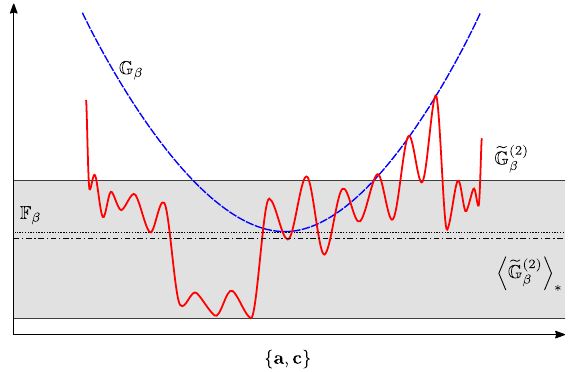
FIG. 2. Cartoon description for estimating the Helmholtz free energy (dotted line) via the Gibbs (blue dashed line) and TAP (red line) free energies. For this example of a convex Gibbs free energy, there exists one unique minimum over the moments a and c , and the Gibbs free energy here matches F β . The range of TAP free energies (gray box) gives a boundary on the location of F β . Averaging the TAP free energies (dash-dotted line) provides an estimate of F β